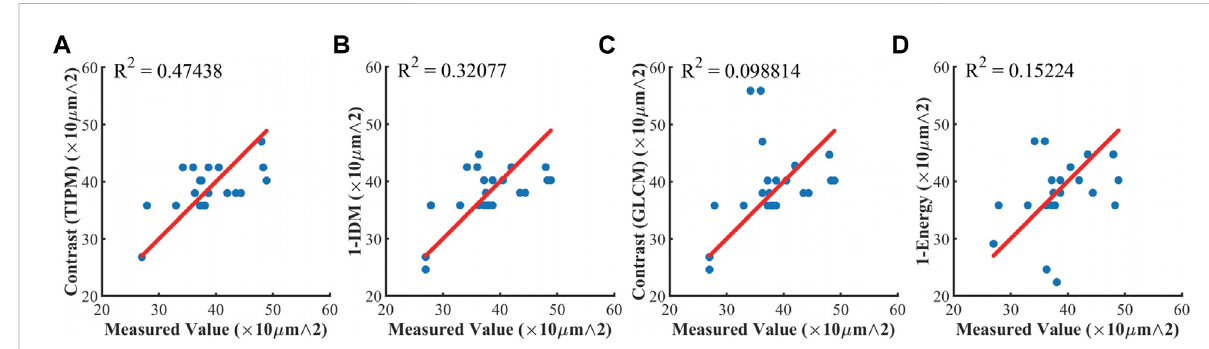
FIGURE 6 Correlation scatter plots between manually measured size value and calculated size value of 23 hair follicles for different polarization texture images. (A) TIPM contrast with p < 0.01; (B) GLCM 1-IDM with p < 0.01; (C) GLCM contrast with p > 0.05; (D) GLCM 1-Energy with p > 0.05. The red lineinsub fi guresshowsy=x,andthedeviationofpointsfromthelinerepresentstheerror.Thestandarddeviationofthemeasuredvalueis6.09.The standarddeviationofTIPMcontrastis4.63.ThestandarddeviationofGLCM1-IDMis4.92.ThestandarddeviationofGLCMContrastis7.28.The standard deviation of GLCM 1-Energy is 6.37.